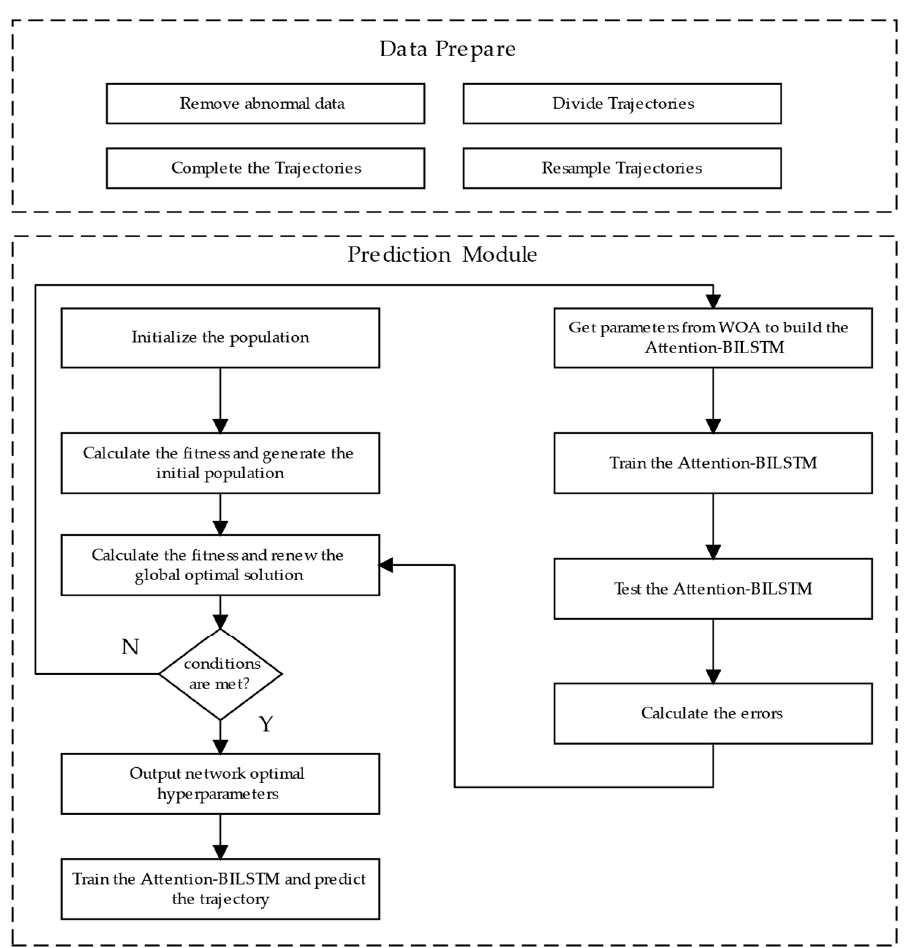
Figure 7. Schematic diagram of WOA-A tt ention-BILSTM model.